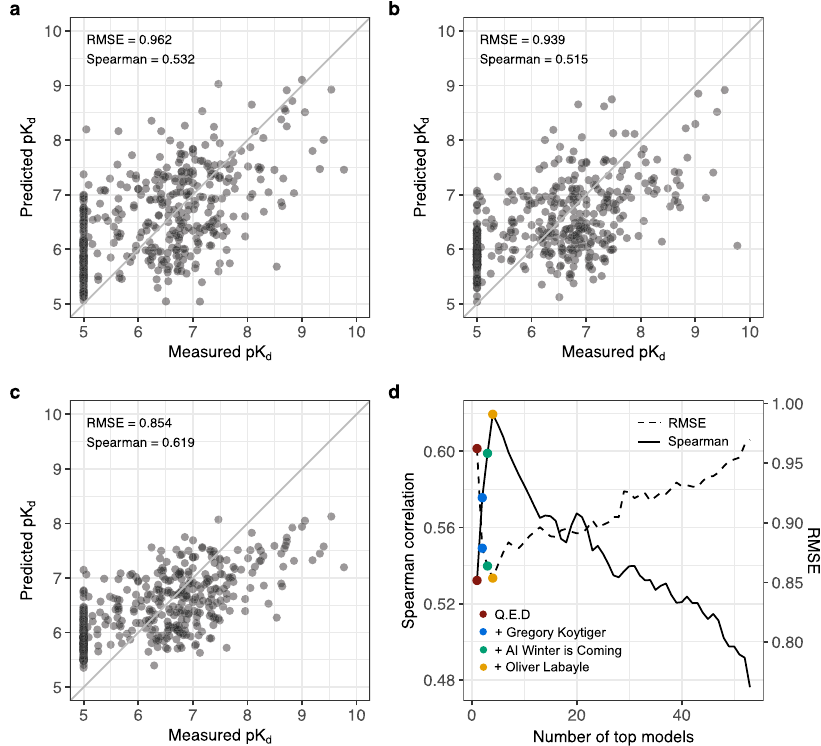
Fig. 4 The top-performing Challenge models and their ensemble combination. a Spearman correlation sub-challenge top performer in Round 2 (Q.E.D). b RMSE sub-challenge top performer in Round 2 (AI Winter is Coming). The points correspond to 394 pairs between 25 compounds and 207 kinases. c Ensemble model that combines the top four models selected based on their Spearman correlation in Round 2. d The mean aggregation ensemble model was constructed by adding an increasing number of top-performing models based on their Spearman correlation (the solid curve), until the ensemble correlation dropped below 0.45. The peak performance was reached after aggregating four teams (marked in the legend; see Supplementary Fig. 9 for all the teams. Note: ensemble prediction from a total of 21 best teams had a signi fi cantly better Spearman correlation compared to the Q.E.D model alone). The right-hand y -axis and the dotted curve show the Root Mean Square Error (RMSE) of the ensemble model as a function of an increasing number of top- performing models. Source data are provided as a Source Data fi le 54